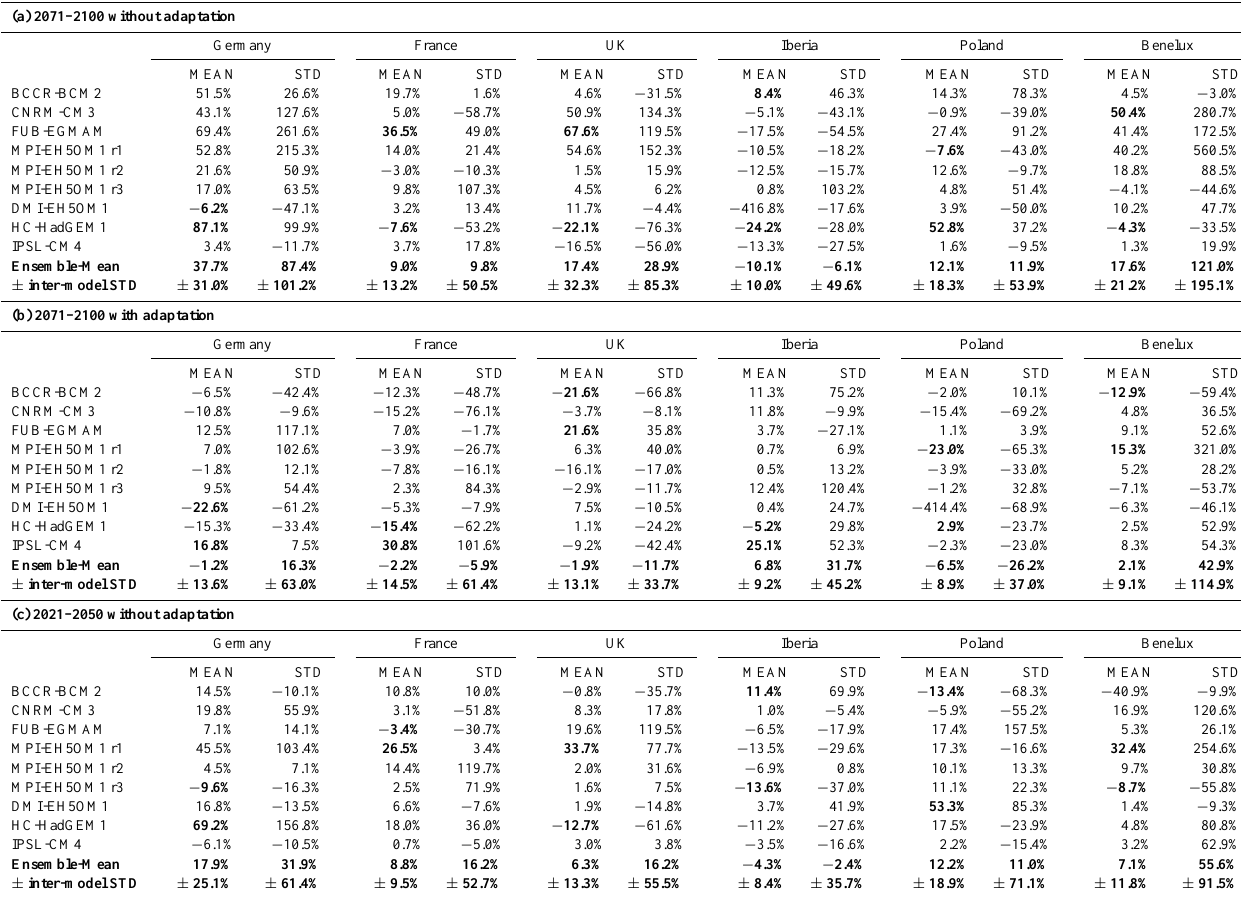
Table A1. ACC signal of simulated loss ratios in the individual GCMs. Relative changes for the future climate periods considered in this study compared to the 20C simulations are presented (unit: percent). For each region, the maximum and minimum changes of mean loss ratios (indicating the maximum spread of the ensemble) are highlighted using bold